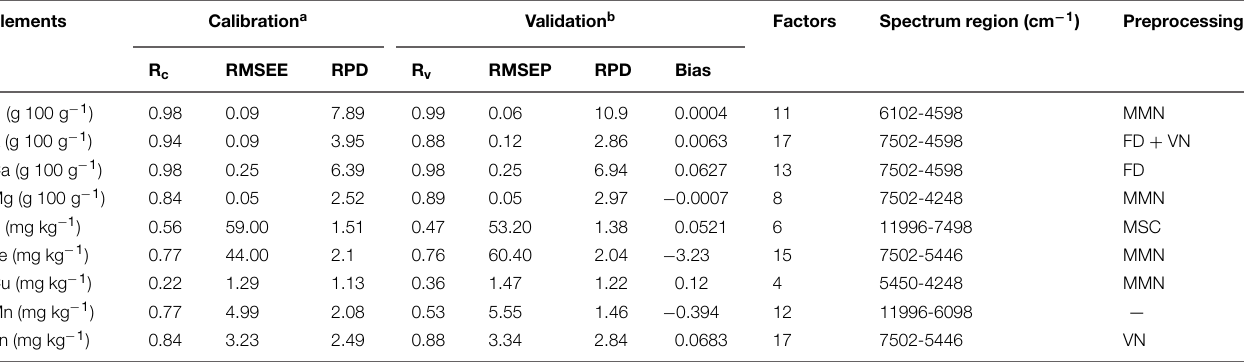
TABLE 3 | Near infrared reflectance spectroscopy calibration and validation results for all studied elements.